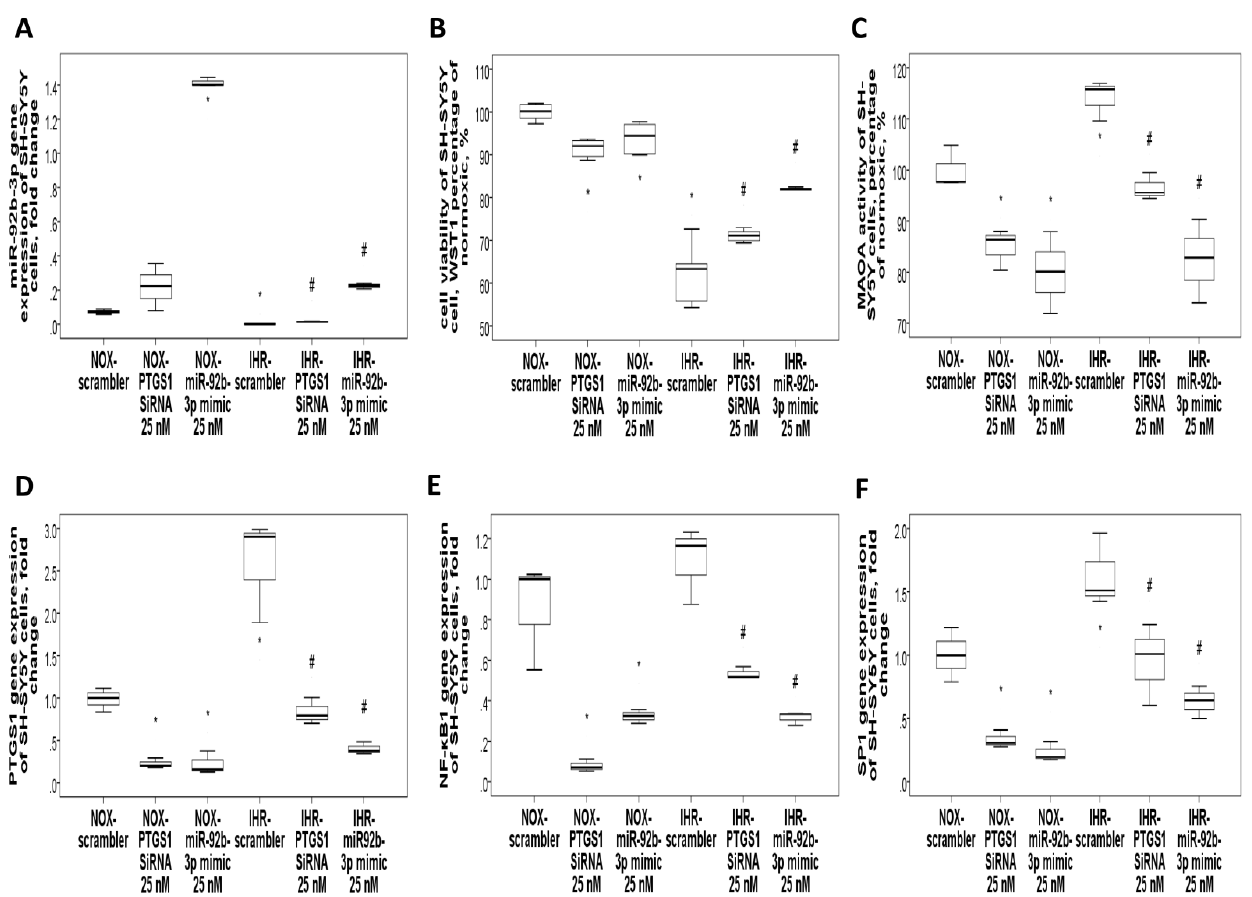
Figure 9. Over-expression of miR-92b-3p or knockdown of PTGS1 reversed intermittent hypoxia with re-oxygenation (IHR)-induced cell injury and MAOA hyperactivity via targeting NF- κ B1/SP1 signaling. Transfection with either PTGS1 SiRNA or miR-92b-3p mimic in SH-SY5Y cells reversed IHR-induced ( A ) down-regulation of miR-92b-3p, ( B ) cell injury, ( C ) MAOA hyperactivity, and up-regulations of ( D ) PTGS1, ( E ) NF- κ B1, and ( F ) SP1. * p < 0.05 compared with normoxic (NOX) condition. # p < 0.05 compared with IHR condition.